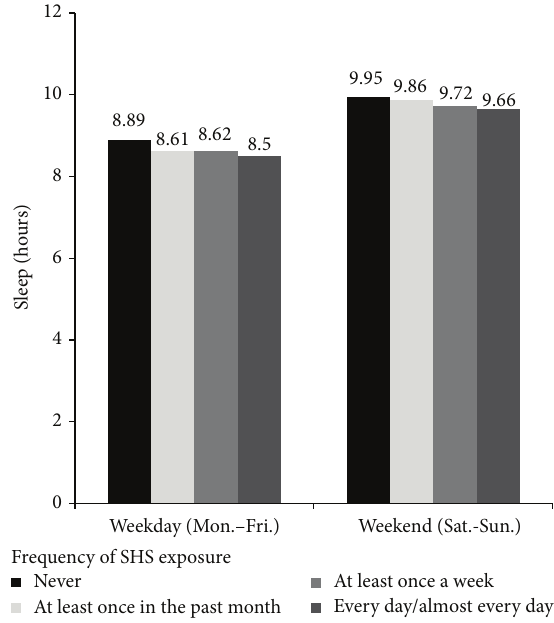
Figure 2: Sleep duration by secondhand smoke (SHS) exposure in the past